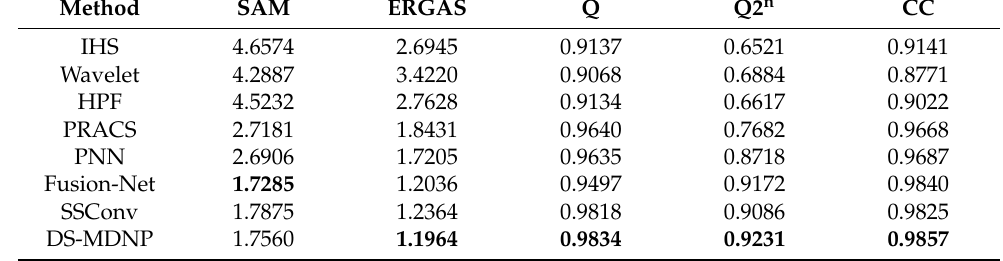
Table 4. Quantitative evaluation comparison of fusion results on the QuickBird dataset. The values in bold represent the best result. Method